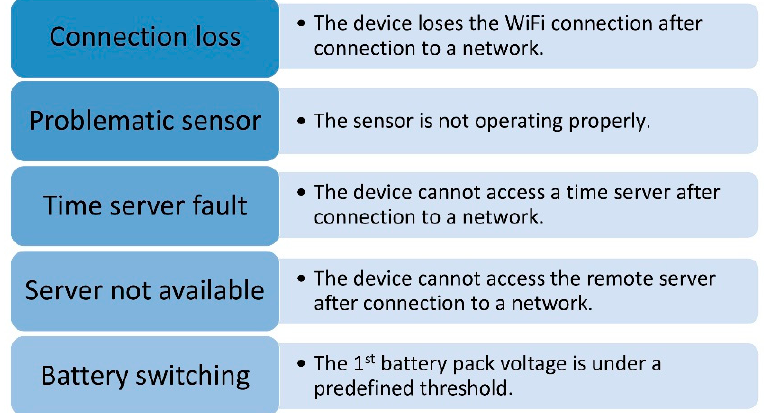
Figure 15. Faulty test conditions.